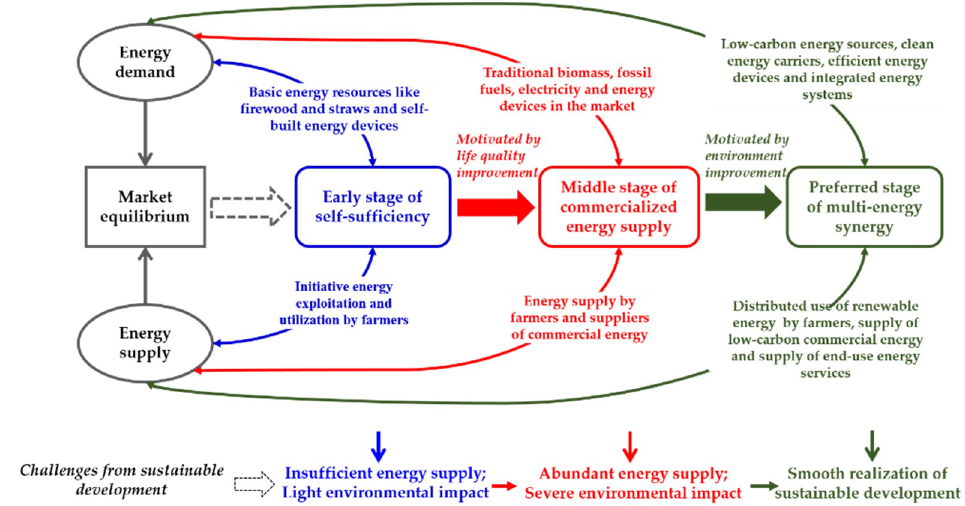
Figure 5. Dynamic evolution of rural household energy development in China.